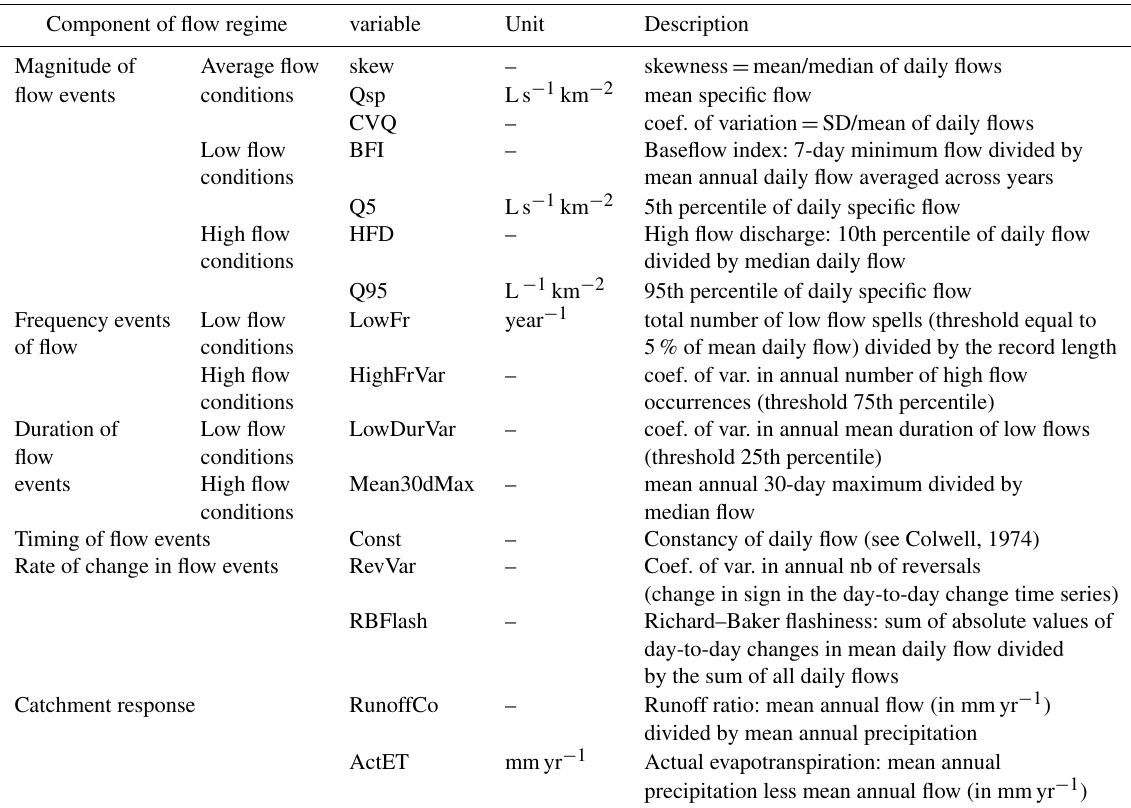
Table 2. Description of the 16 flow signatures